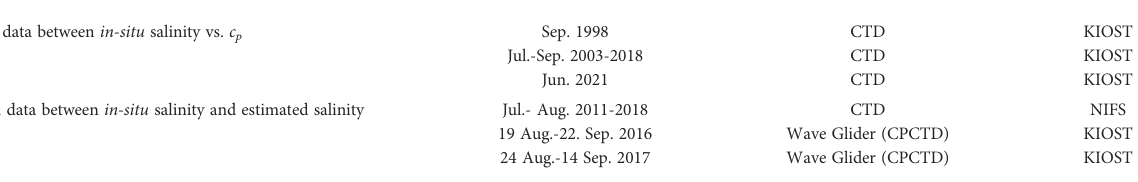
TABLE 1 In-situ measurement data collected from KIOST and NIFS research cruise. Match-up data between in-situ salinity vs. c